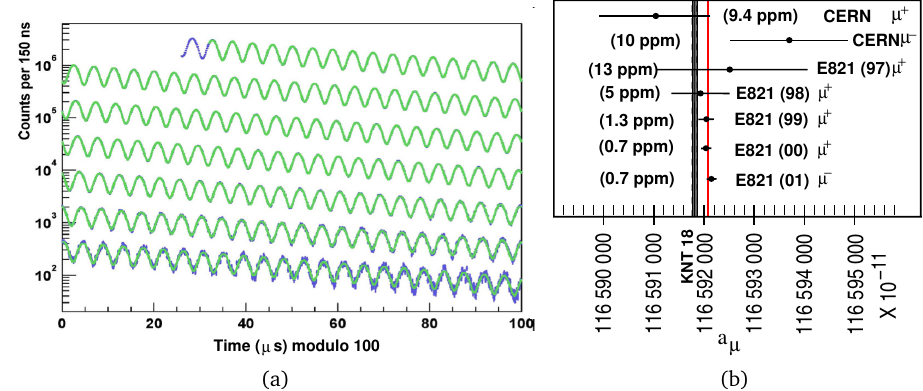
Figure 12: (a) The arrival time spectrum from the 2001 data set [ 51 ] . The blue points are data and the green curve is the fit to the data. The histogram contains (cid:39) 3 × 10 9 events. (b) The measurements of a µ from CERN-3 and from BNL E821. The vertical band labeled KNT shows the Standard Model value from Keshavarzi et al. [ 54 ] . The thin vertical line is the combined average of the individual